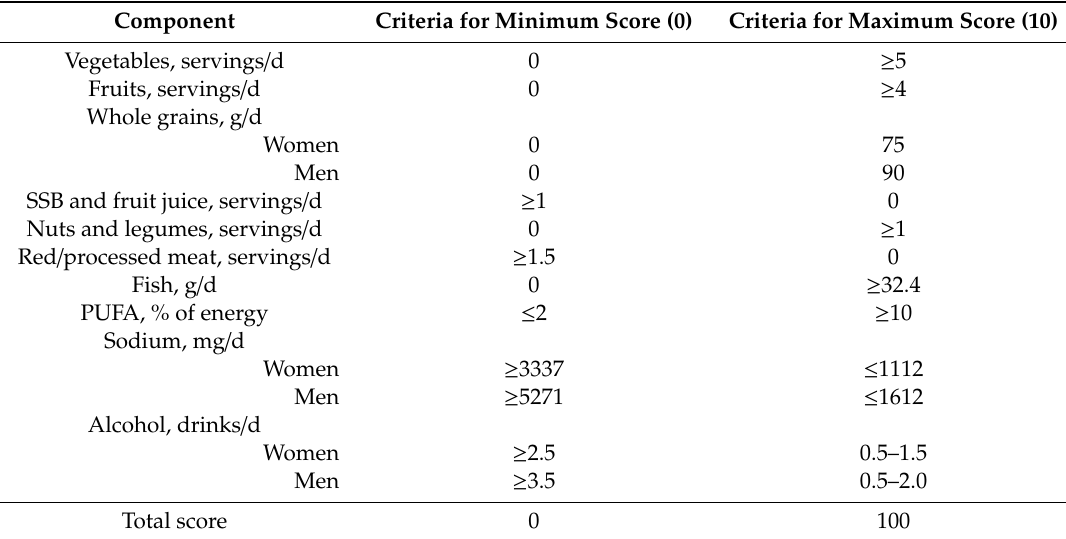
Table 2. Criteria for the definition of the Mediterranean Diet Score [10]. Component Criteria for Maximum Score (1) Women Men Vegetables ≥ 181.50 g ≥ 148.50 g Legumes Fruits and nuts Cereals